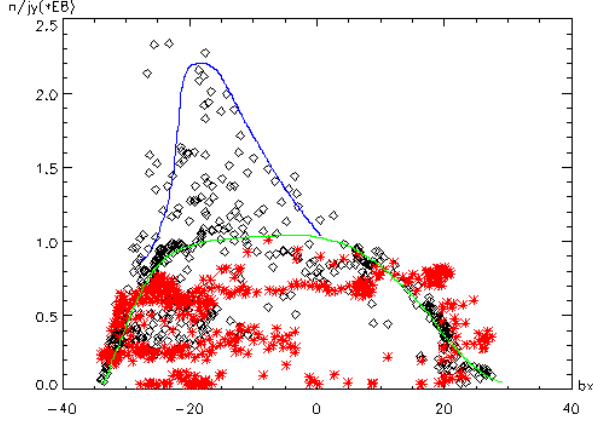
Fig. 3. The scattering plot of the current density together with the proton density versus Bx